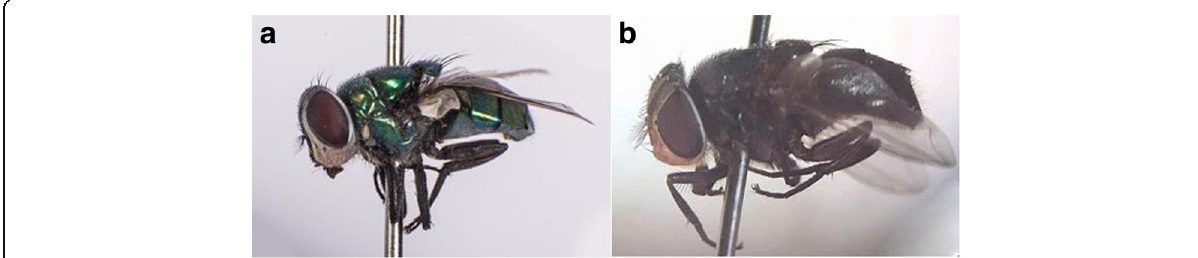
Fig. 1 Pictures of Chrysomya albiceps (a) and Calliphora vicina